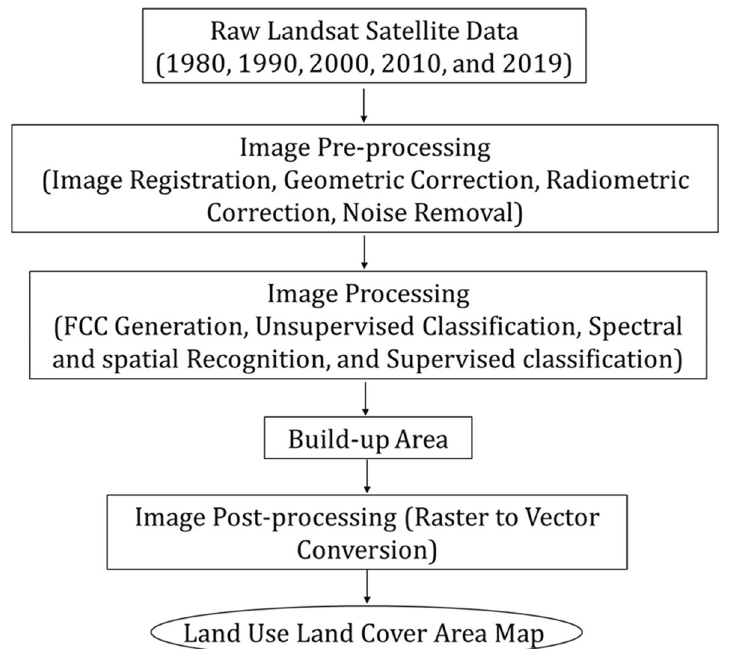
Fig. 3 Flowchart of methodology used for LULC